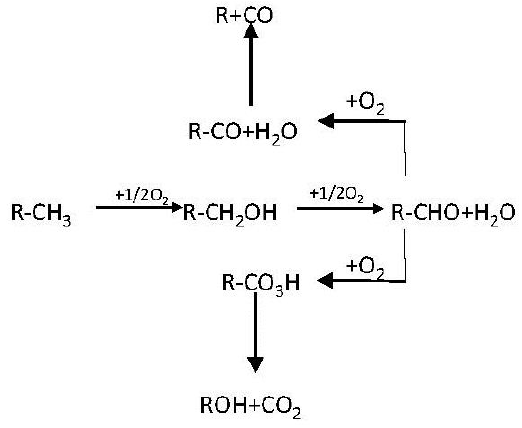
Figure 1. Chemical reaction equations of low temperature oxidation.